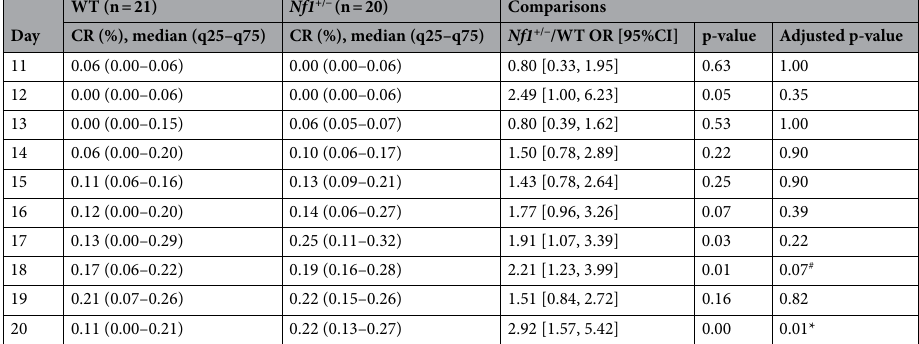
Table 4. “Perfectly timed” CR proportion in the 500 ms ISI training phase. An odds ratio (OR) > 1 indicates a higher CR proportion in the Nf1 +/− mice over the wild type (WT) mice. # Trend towards a significant difference between genotypes of p < 0.1. *Significant difference between genotypes of p <